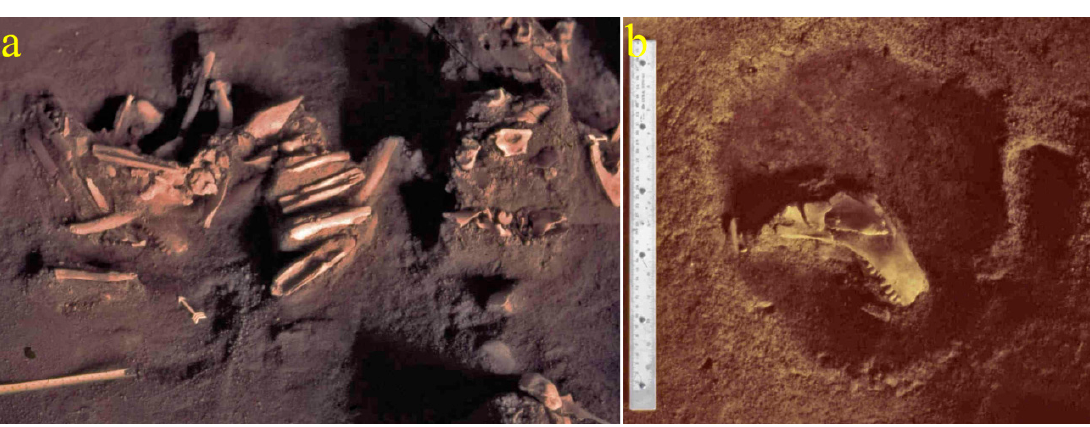
Figure 10. Relationship between the percentages of completeness (% Comp.) and the minimum number of individuals (MNI)/minimum number of skeletal elements (MNE) according to the different taxa exhumed in layer four. The rectangles show the consumed species (modified after Figure 6.2.7 of [31]). References—1: Lama Guanicoe and Lama cf. owenii , 2: Hippidion saldiasi , 3: Mylodon cf. dawinii , 4: Canidae (enclose at least Dusicyum avus ).